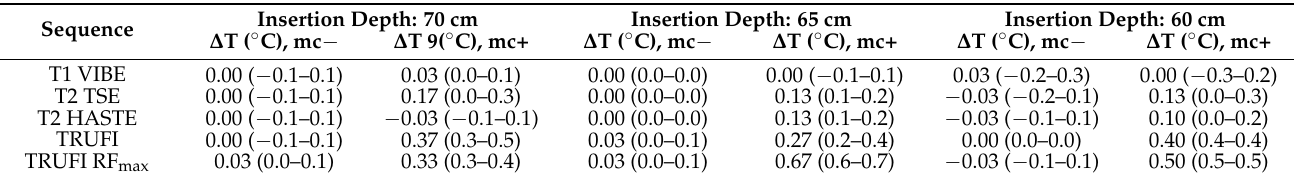
Table 2. Radiofrequency-induced heating of the shaft of catheter A in two orientations: without microcatheter inserted (mc − ) (Figure 1A), and with microcatheter inserted (mc+), during which it was positioned extremely close to the bore (Figure 1B). Range of maximum temperature differences is presented within brackets.